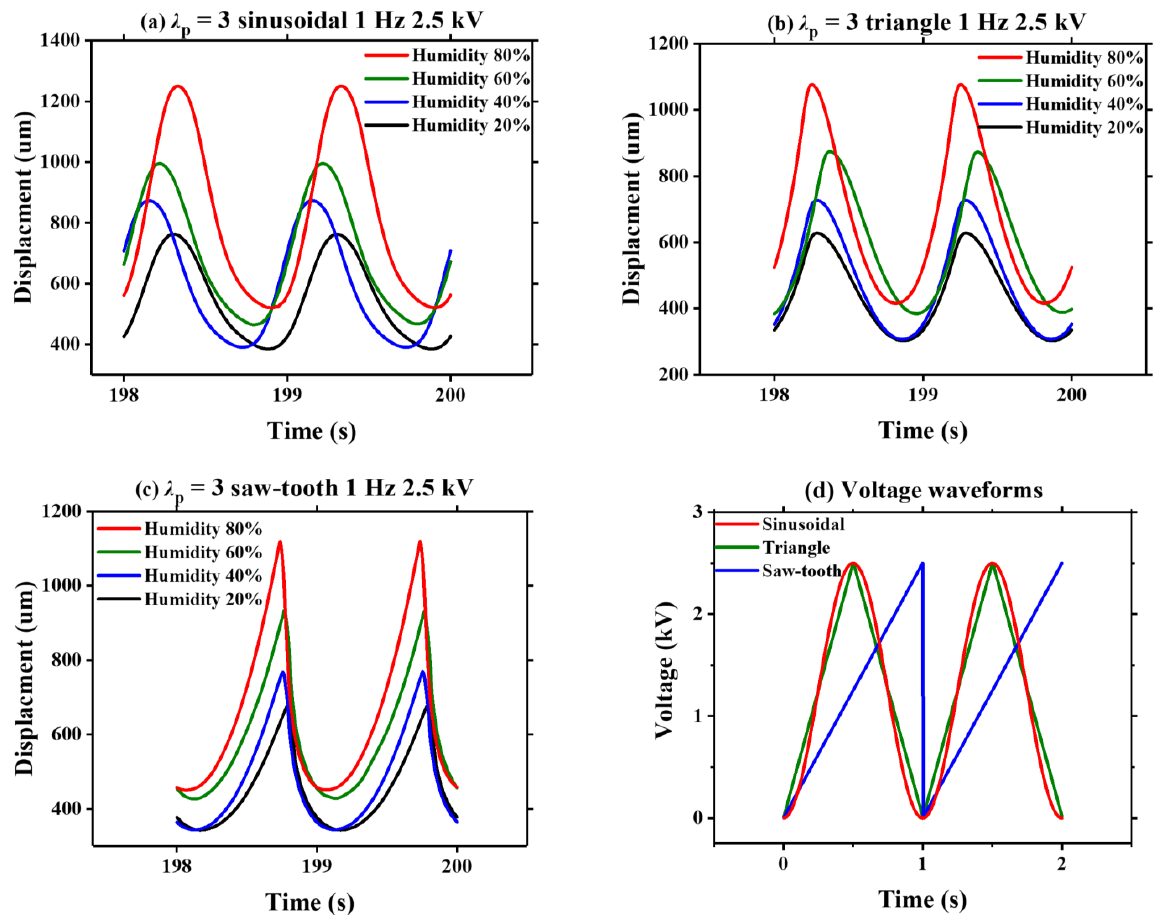
Figure 3. Displacements induced by three voltage waveforms under different humidity levels (20%, 40%, 60% and 80%): ( a ) sinusoidal signal, ( b ) triangle signal and ( c ) saw-tooth signal; ( d ) three voltage waveforms with a frequency of 1 Hz and peak voltage of 2.5 kV.